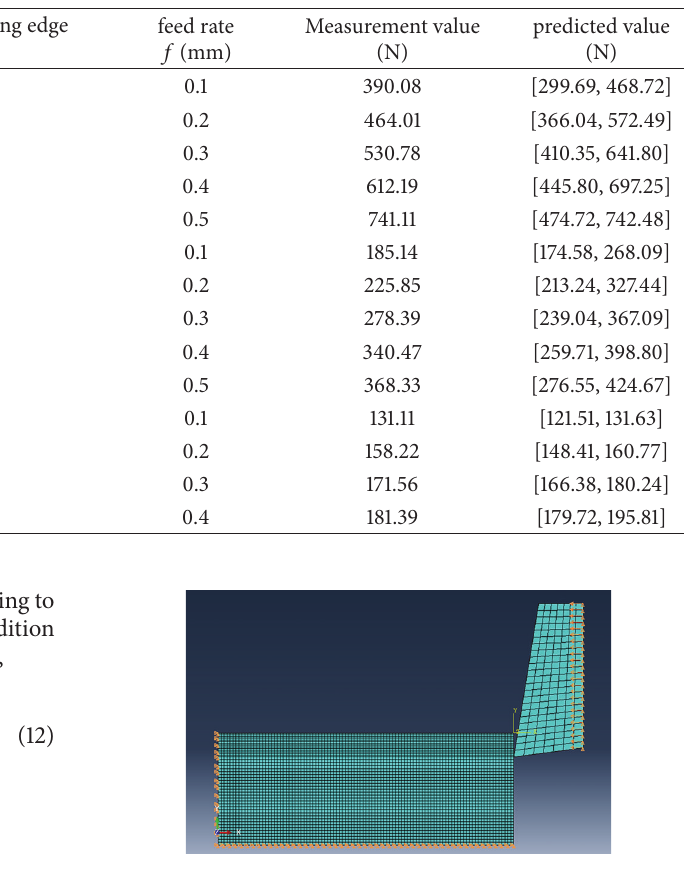
Figure 3: Finite element simulation model by